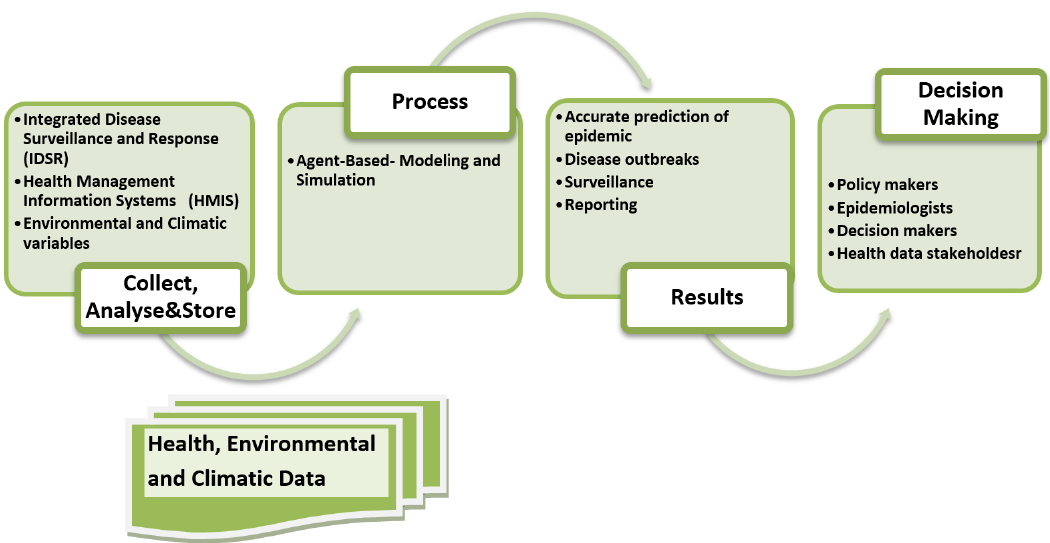
Figure 3. Proposed ABM model components for dengue modeling.